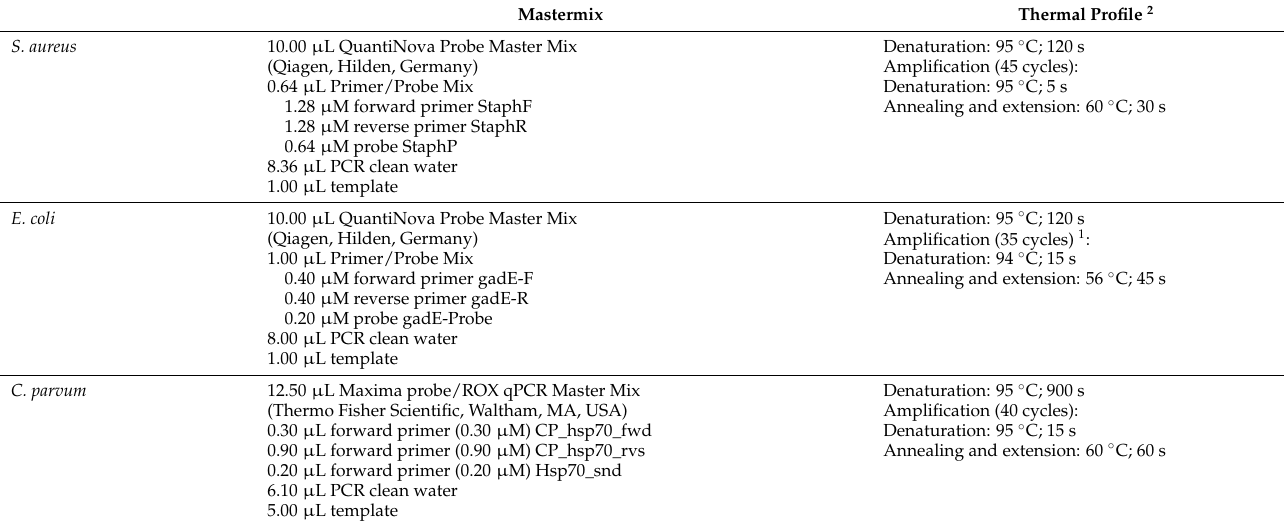
Table 2. Real-time PCR protocols for S. aureus , E. coli and C. parvum